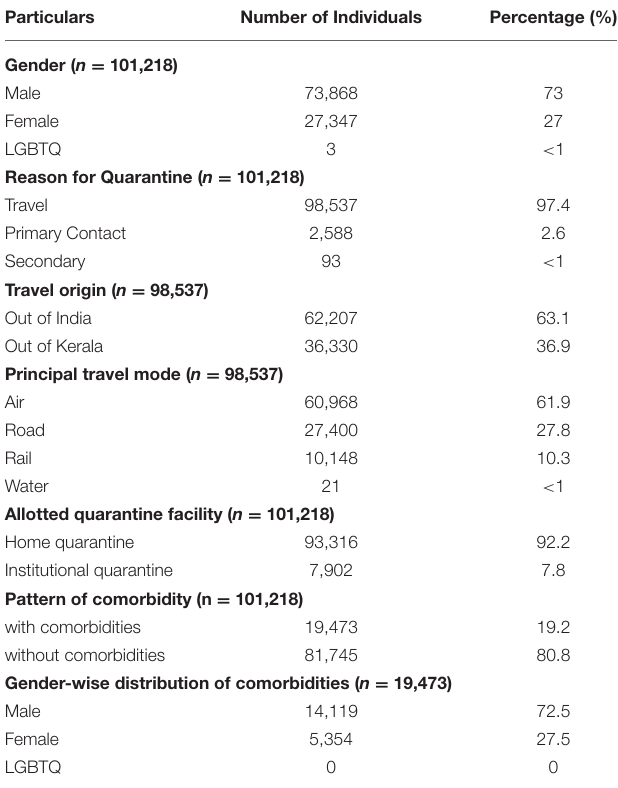
TABLE 3 | Gender, domicile, travel, quarantine facility and comorbidity patterns of quarantined individuals under Amritham from 21 May 2020 to 8 July 2020.